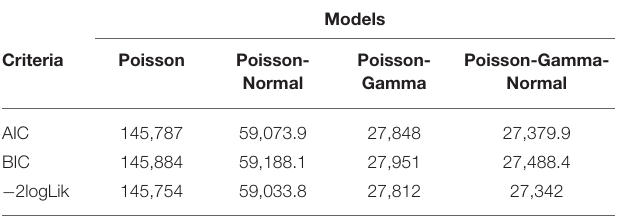
TABLE 7 | Summary of information criteria of different models.